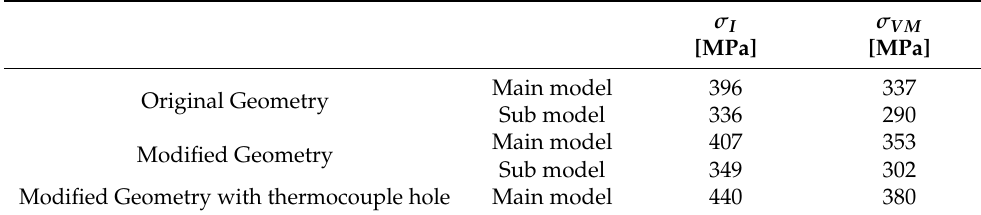
Table 3. Maximum tooth root stress estimated by the FE